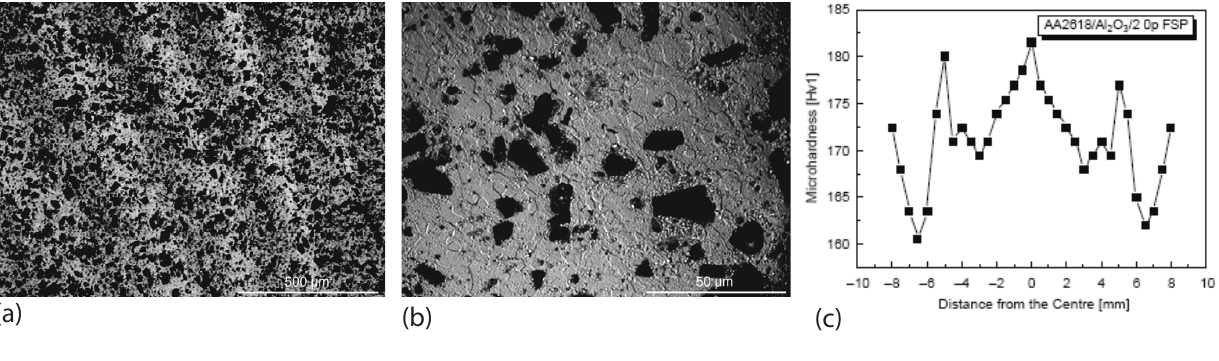
Figure 6 . Different zones generated by friction stir processing as revealed by morphology and microhardness profile (after Cavaliere [61]): (a) micrograph showing the deformation bands in TMAZ; (b) recrystallization in nugget zone; (c) microhardness profile in the FSP Al O /AA2618 2 3